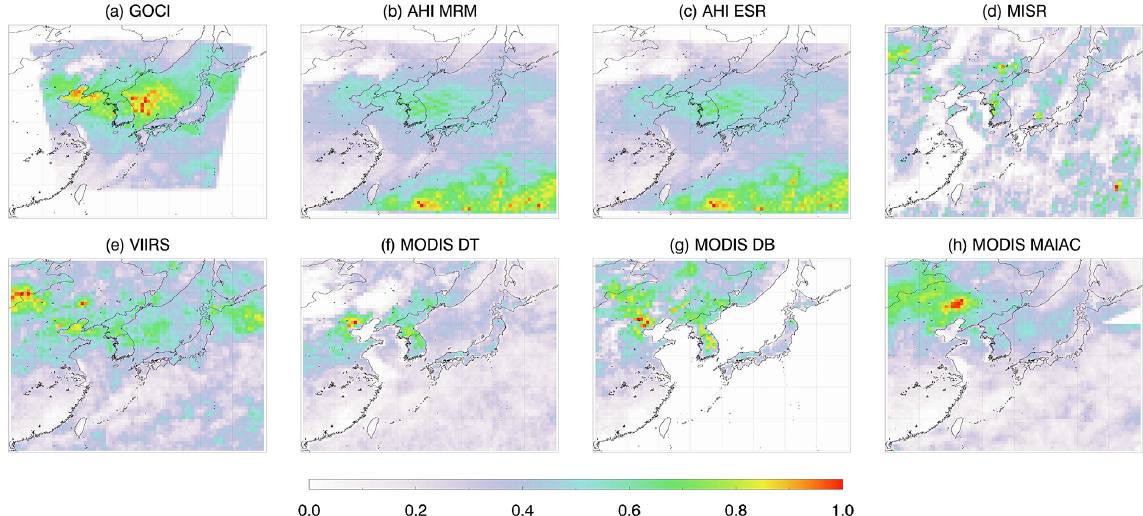
Figure 8. Relative sampling frequency of L2 AOD pixels used to calculate mean AOD of (a) GOCI, (b) AHI MRM, (c) AHI ESR, (d) MISR,